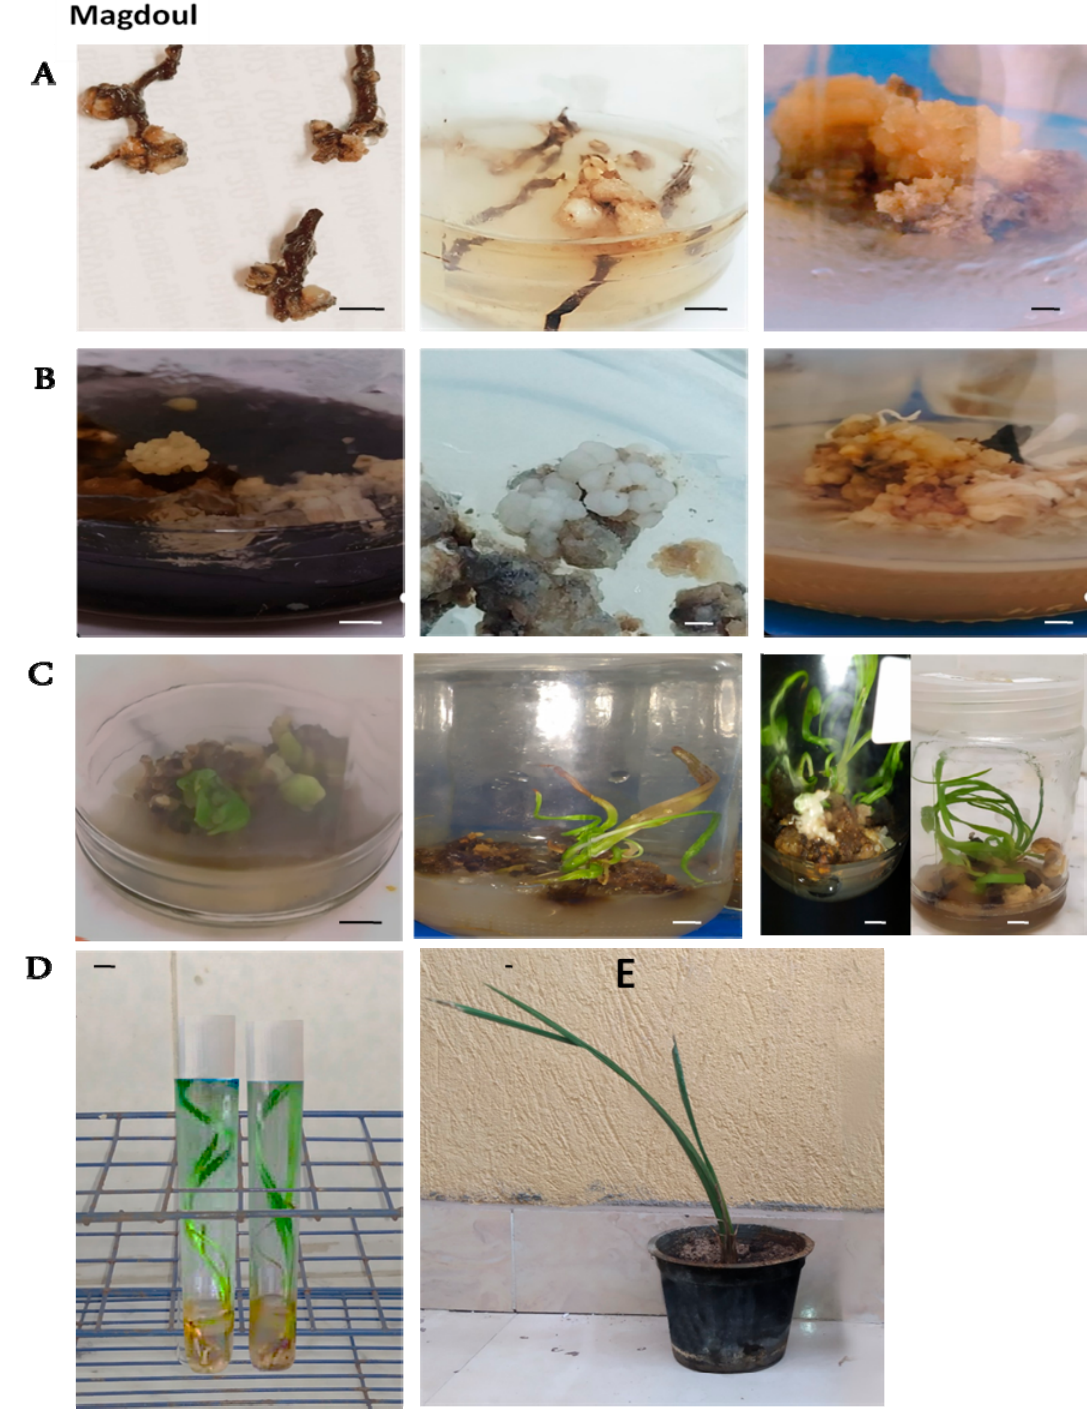
Figure 3. Date palm micropropagation by immature female inflorescences in Magdoul variety. ( A ). Various structures of callus formation and development on starting media after the first subculture, the second subculture and the third subculture, respectively (from left to right). ( B ). Matured embryogenic calli and development of somatic embryogenesis under darkness after 8 weeks, 12 weeks and 16 weeks, respectively (from left to right). ( C ). Germinated somatic embryos and shoot multiplication after 4 weeks, 6 weeks and 12 weeks, respectively (from left to right). ( D ). Shoot rooting. ( E ). Acclimatized plantlets. Scale bar: 1 cm.